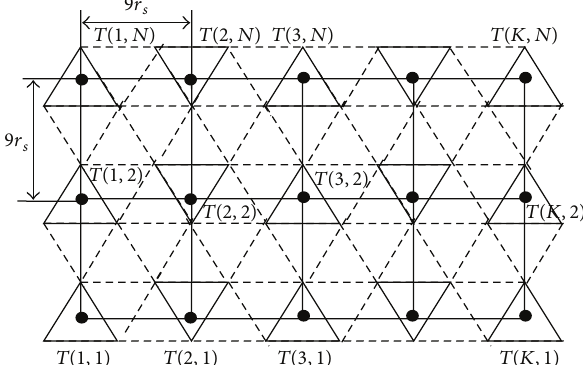
Figure 3: Triangular grid graph redrawn as rectangular grid